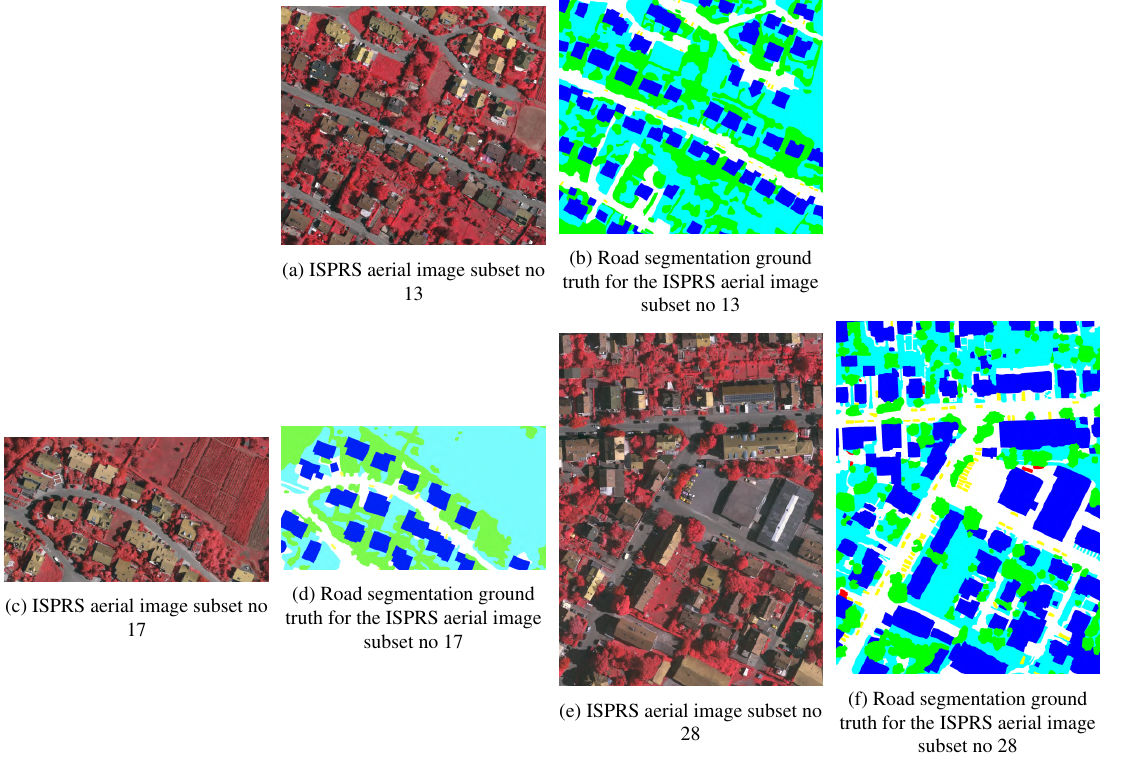
Figure 2. The aerial images used in experiments (Find full resolution at: https://doi.org/10.6084/m9.figshare.14387186.v2 )